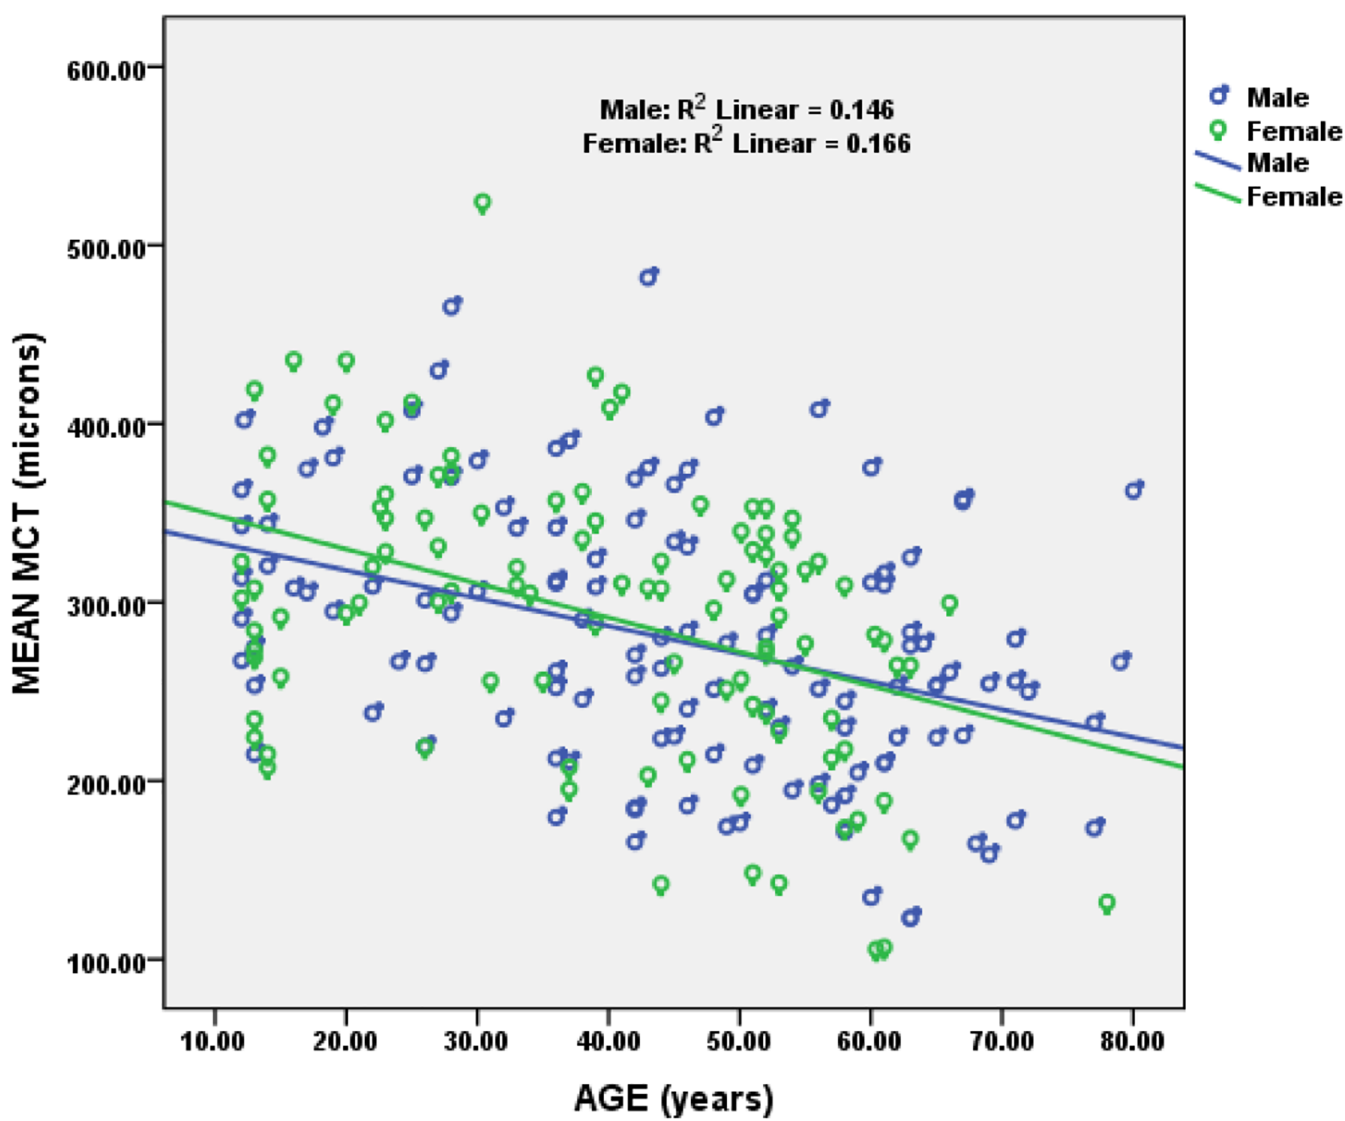
table. It was found that choroidal thickness measurement at different points was highly repeat- able with high ICC values. Inter-observer variability: Agreement between two observers in manual measurement of choroidal thickness was assessed for 15 eyes using Bland Altman Plot (Fig 8). A good agreement was found between two observers for 13 different point